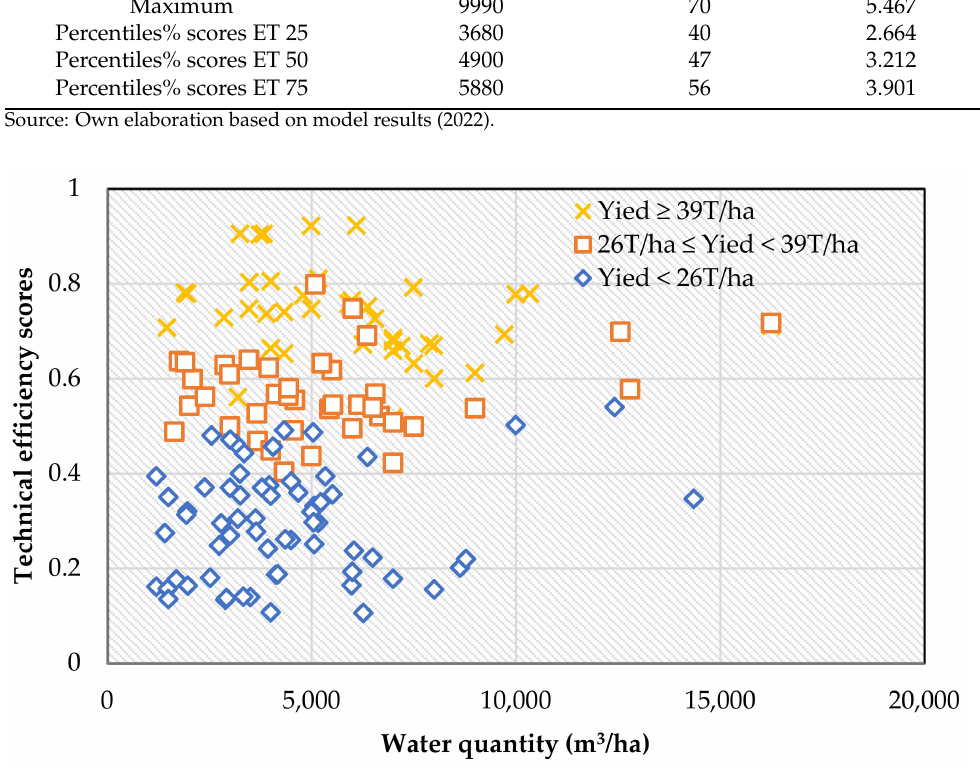
Figure 2. Technical efficiency scores per quantity of water consumed and average yields. Source: Own elaboration based on model results